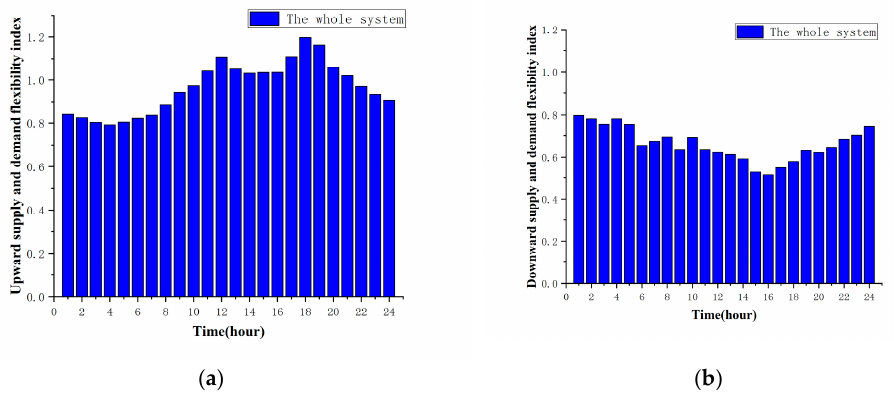
Figure 10. Supply and demand flexibility index of the whole system. ( a ) upward. ( b ) downward.